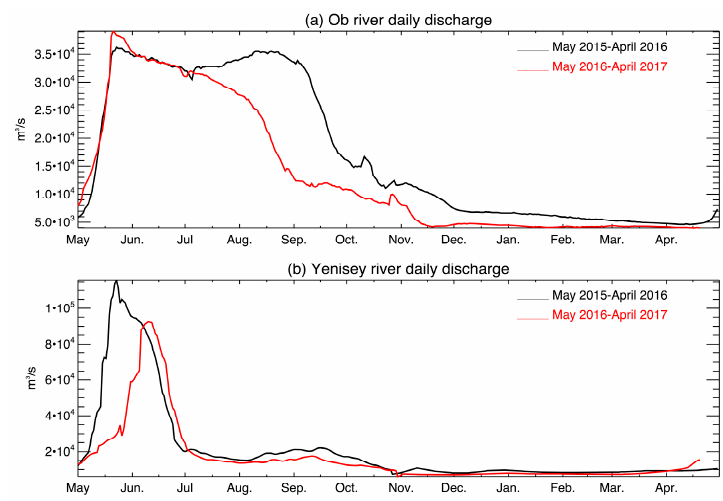
Figure 7. Similar as Figure 6 for HYCOM SSS.